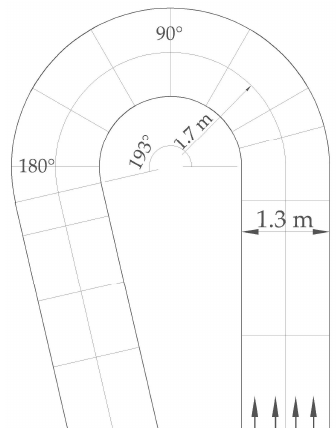
Figure 3. Plan view of Blanckaert’s laboratory flume.